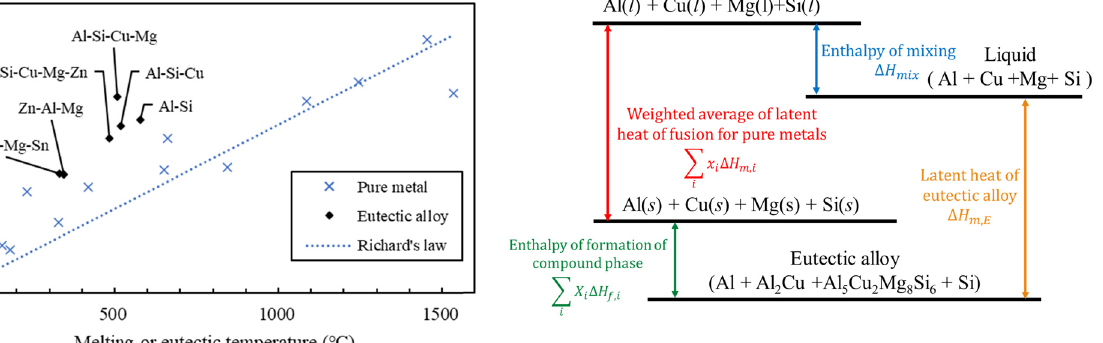
Figure 7: Enthalpy relation between each state for Al – Si – Cu – Mg ( x i : eutectic composition, X i : quantity of compound phase in eutectic alloy )